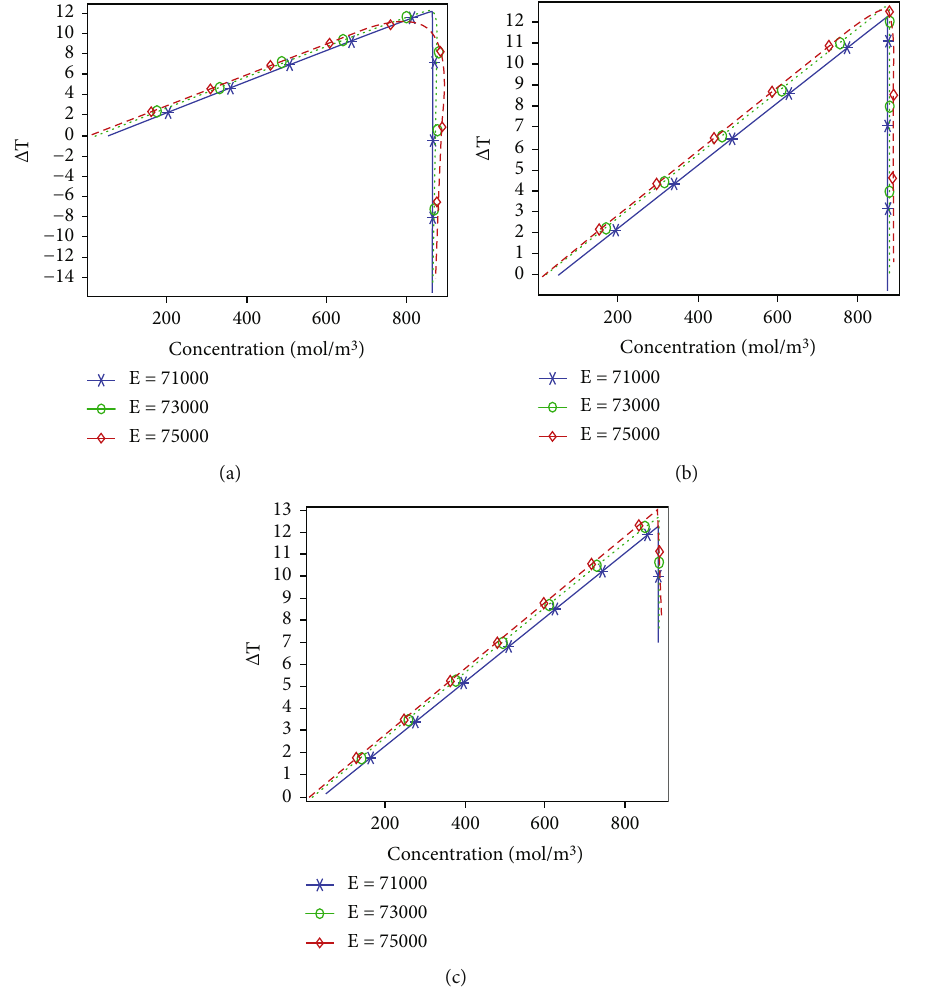
Figure 7: Change in the temperature at upstream along the backstep channel against the concentration of calcium hydroxide at (a) Re = 100 , I : C = 2 % , a = 0 : 5 ; (b) Re = 100 , I : C = 2 % , a = 0 : 6 ; and (c) Re = 100 , I : C = 2 % , a = 0 : 7